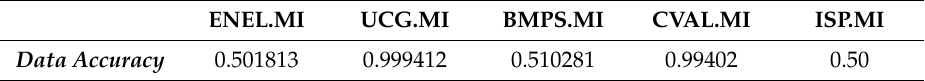
Table 3. ENEL.MI, UCG.MI, BMPS.MI, CVAL.MI, and ISP.MI Data Accuracy (DA) results.